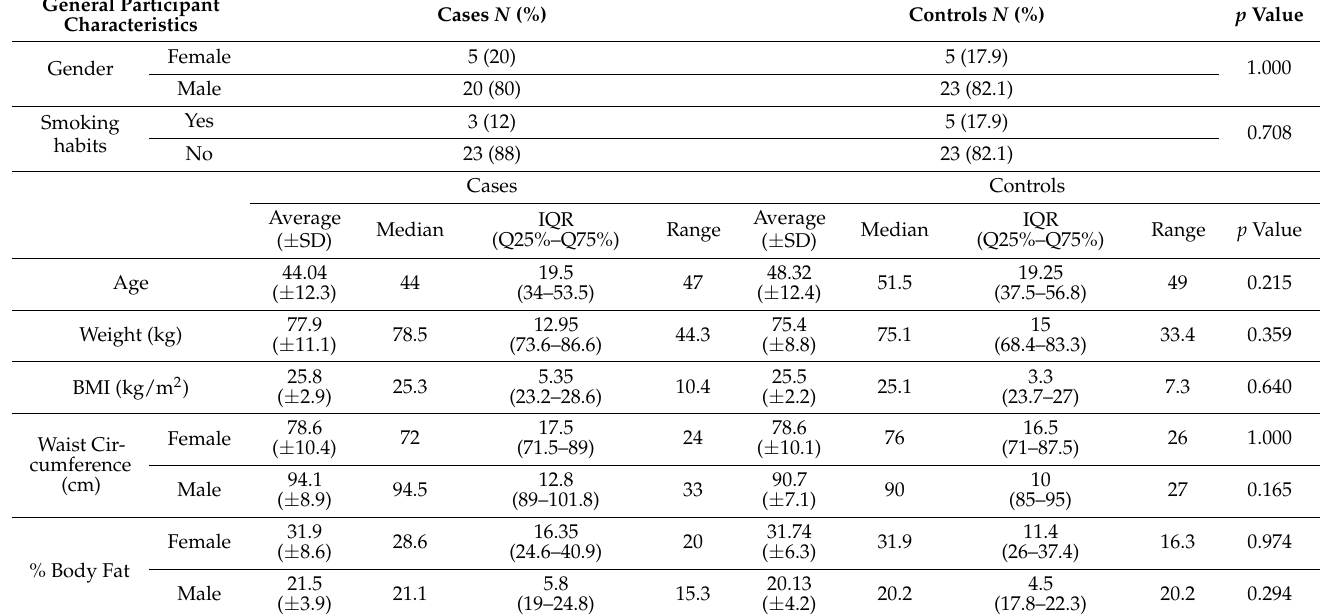
Table 1. General participant characteristics.